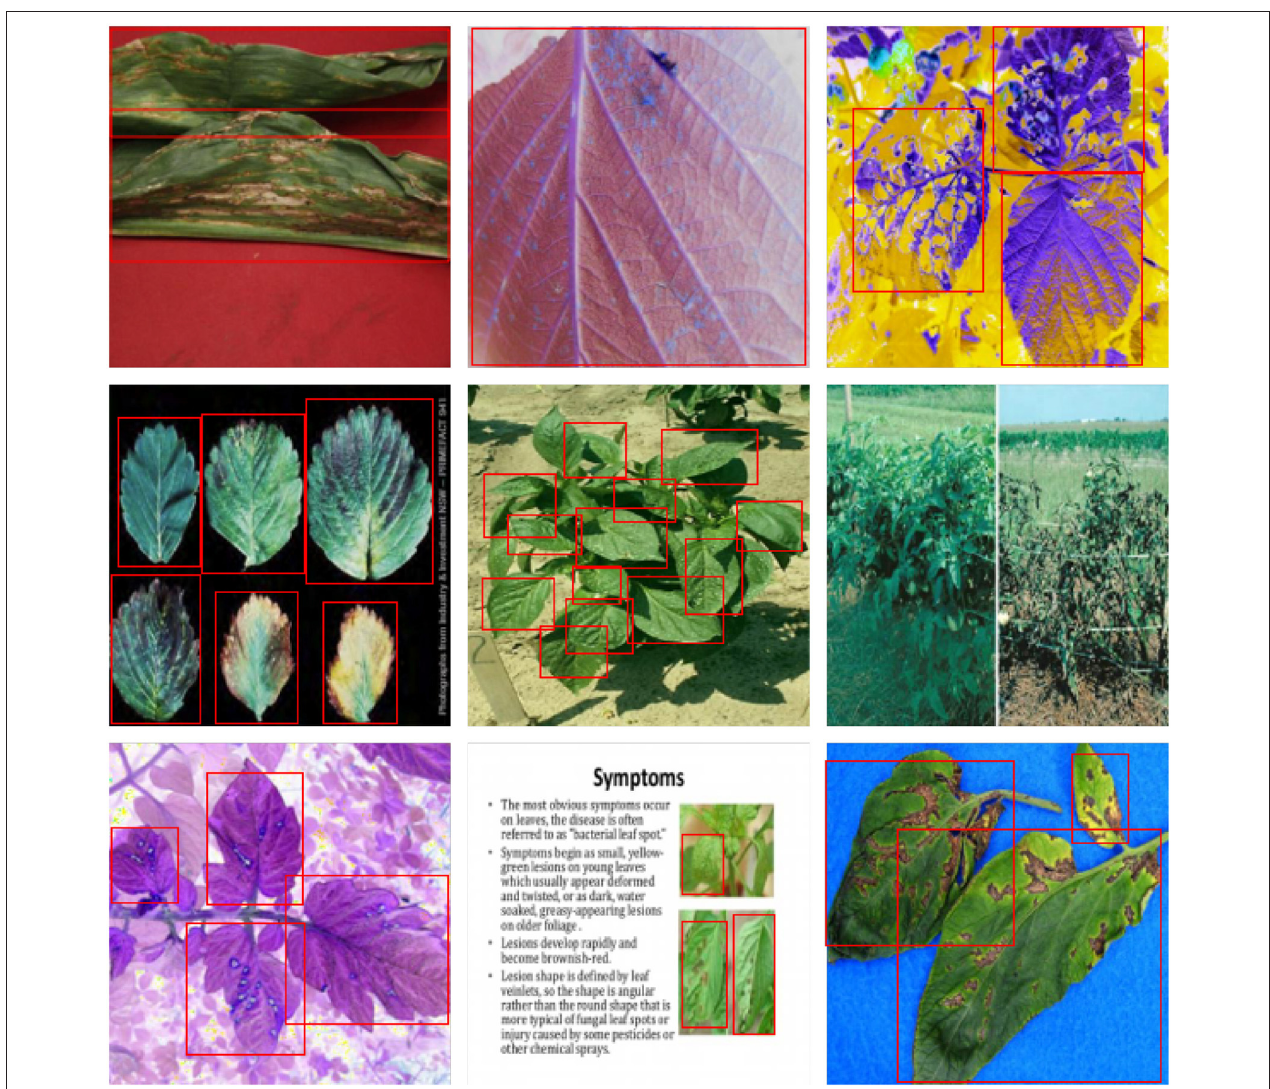
FIGURE 7 | The detection results of YOLO v3 in the